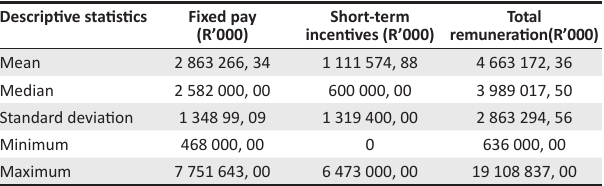
TABLE 1: Descriptive statistics: Chief executive officer remuneration components for the data set